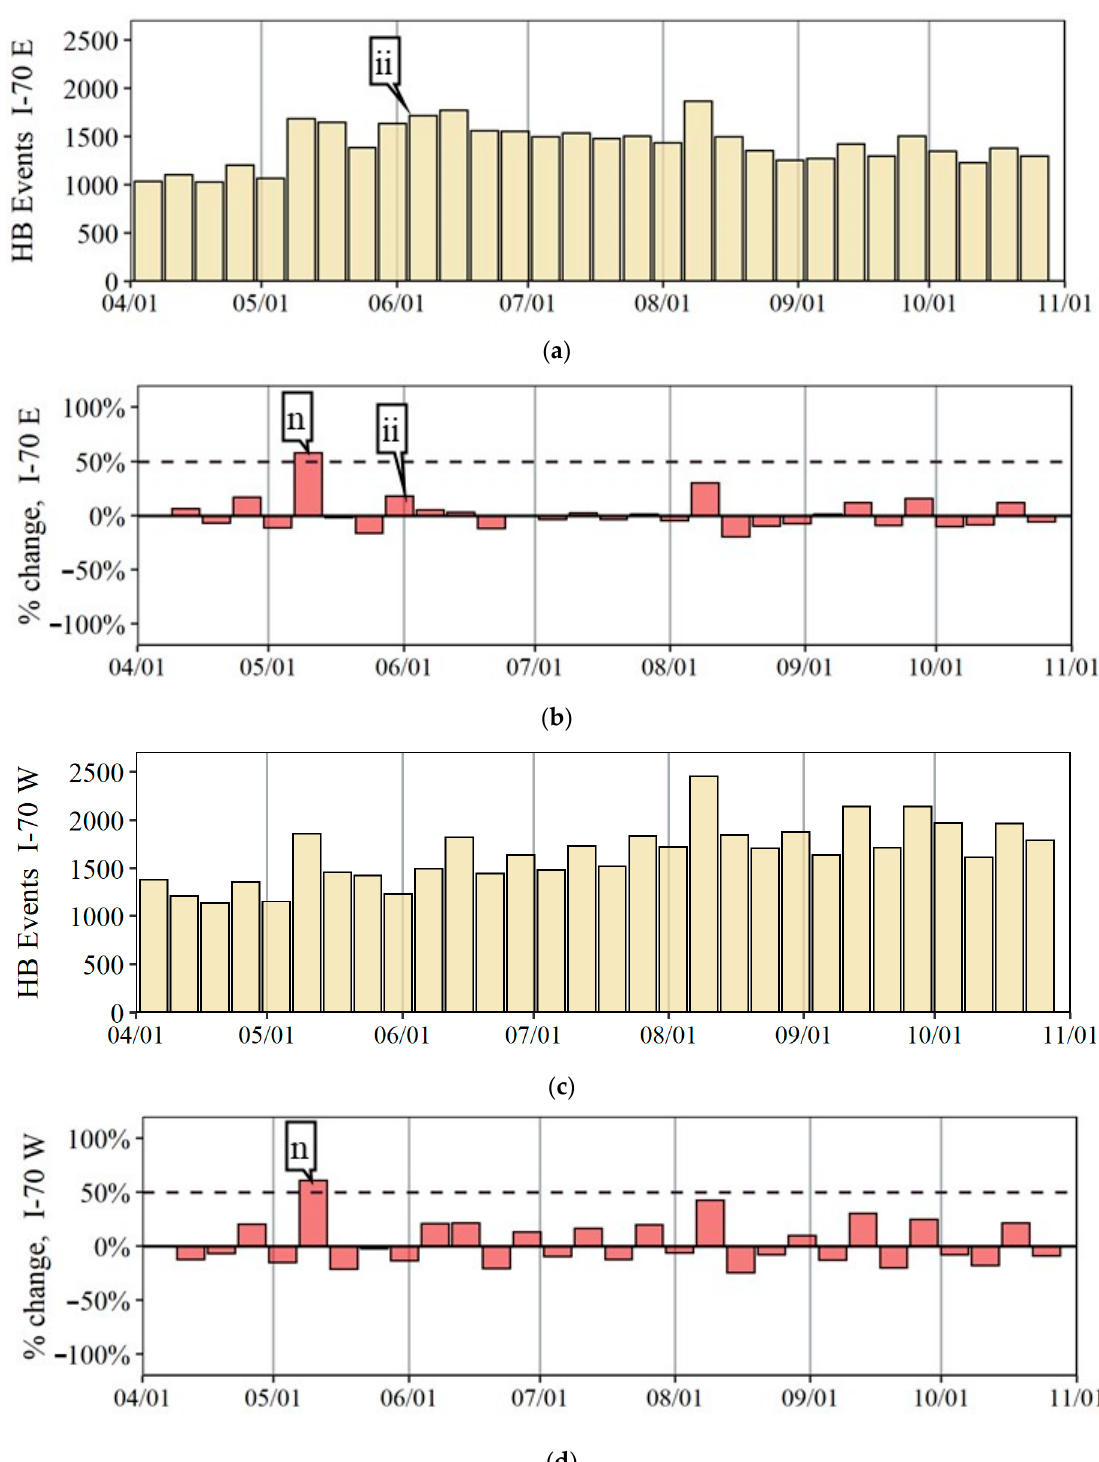
Figure 8. Comparison of hard-braking events across I-70. ( a ) Weekly hard-braking events (east- bound); ( b ) Percentage change in hard-braking events from previous week (eastbound); ( c ) Weekly hard-braking events (westbound); ( d ) Percentage change in hard-braking events from previous week (westbound).